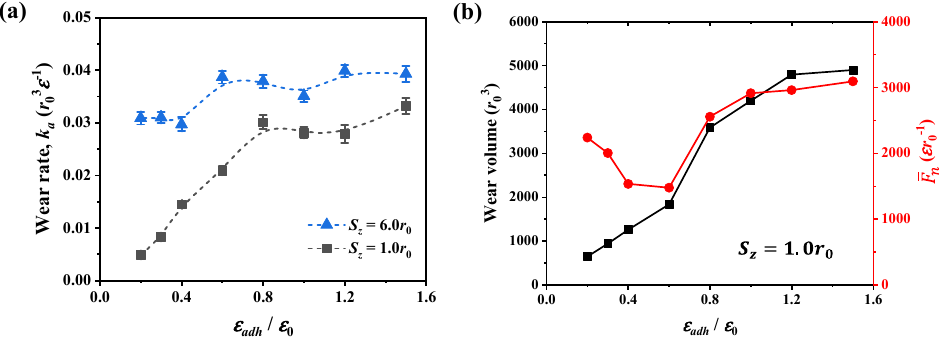
Figure 6. ( a ) Wear rate at two scratch depths as the interfacial adhesion changes, and the dashed lines are guides for eyes. ( b ) Wear volume and averaged normal force at the depth of 1.0 r 0 . The wear volume is obtained at the scratch distance of 60 r 0 .